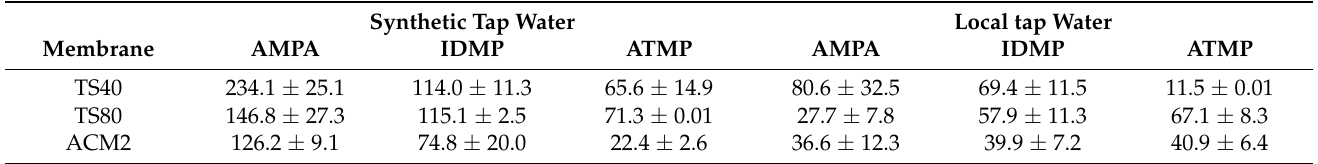
Table 3. Determined phosphonate concentrations in different permeates based on TP analyses ( µ g L − 1 ). Synthetic Tap